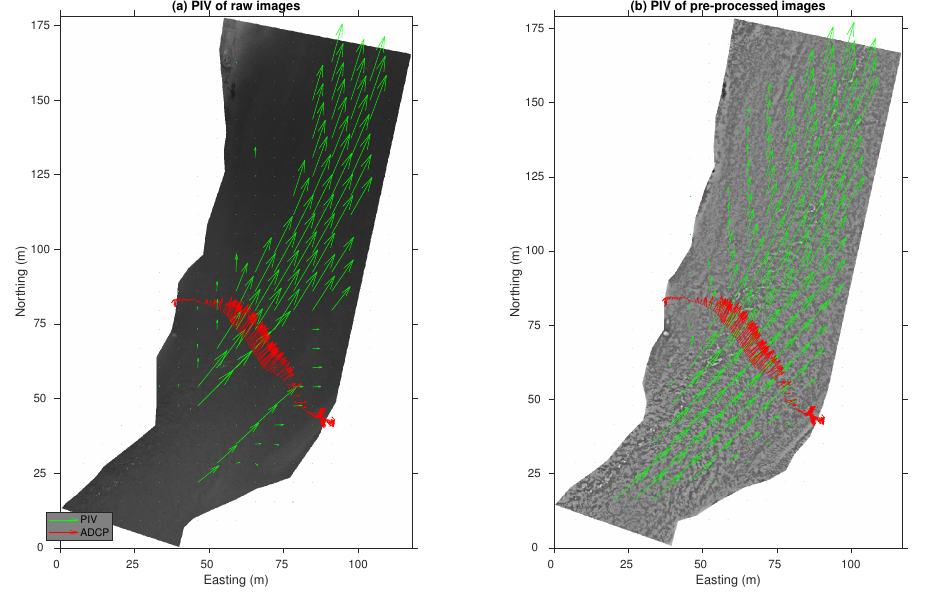
Figure 5. Comparison of PIV-derived velocity vectors derived from ( a ) raw images and ( b ) images preprocessed via FIJI. Image pixel size is 10 cm in both cases and the velocity vectors measured in the field with an ADCP are overlain in red for